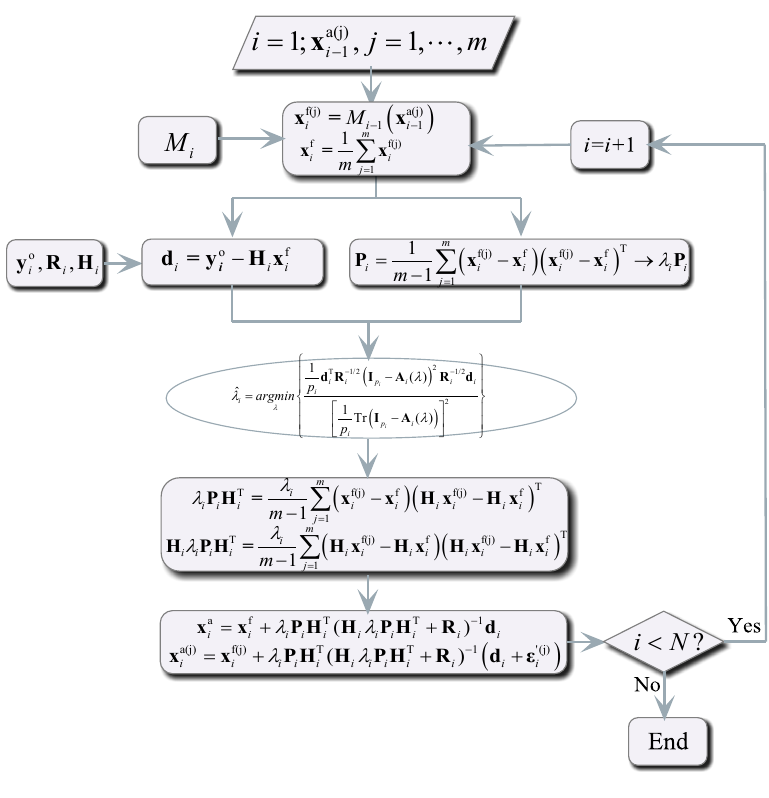
Figure 1. Flowchart of the proposed assimilation scheme.